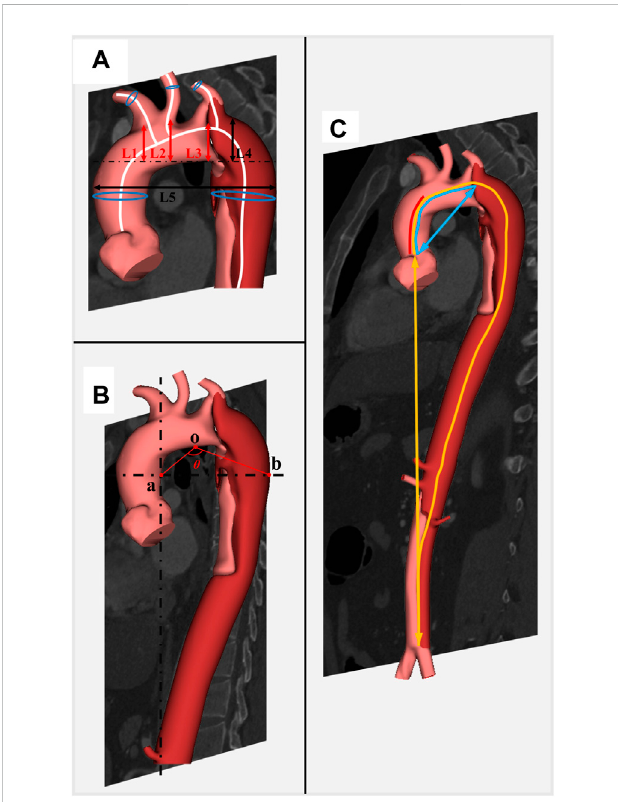
FIGURE 1 Detailed illustration of morphological parameters related to development of TBAD. Caption: BCT, brachiocephalic trunk; LCA, left carotid artery; LSA, left subclavian artery. (A) L1, L2, and L3 represent the height of BCT, LCA, and LSA, respectively; L4 and L5 represent the height of aortic arch and the width of aorta, respectively; blue circles represent the diameters on the centerline. (B) Angle θ represents the degree of question mark. (C) Centerlines of red, blue, and yellow represent the length of the ascending aorta, ascending aorta and aortic arch, and total aorta; the blue straight line represents the distance between the aortic root and the aortic arch; the yellow straight line represents the distance between the aortic root and the end of descending